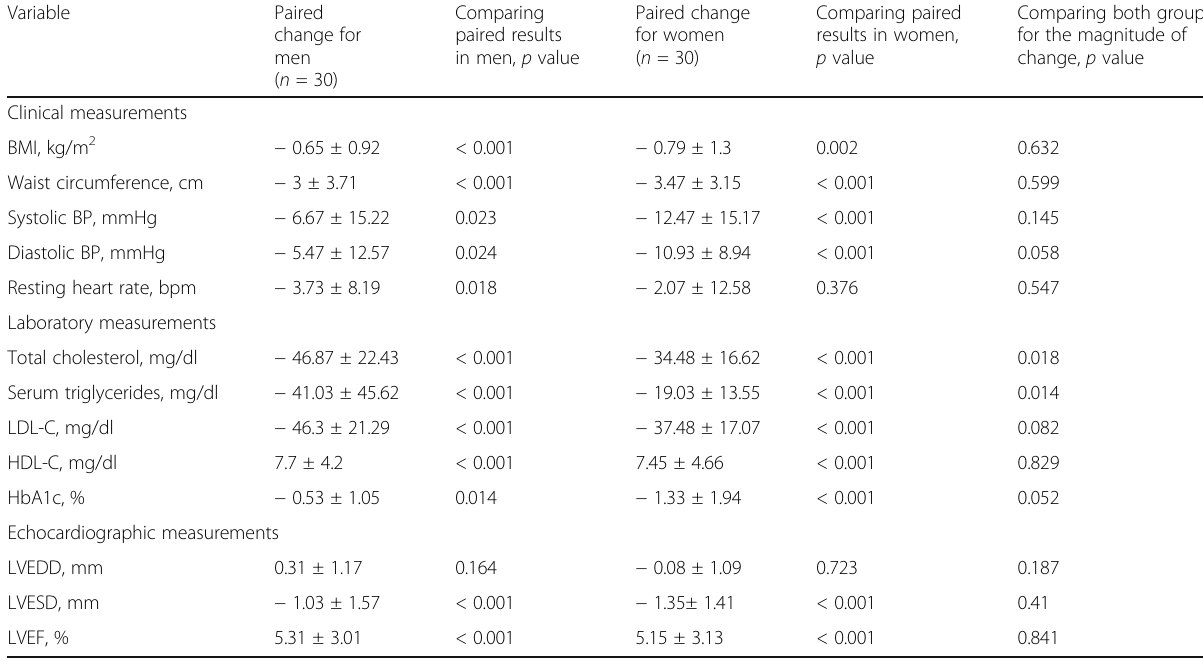
Table 4 Paired change in clinical, laboratory and echocardiographic measurements after completion of the cardiac rehabilitation program for each gender and comparison of the magnitude of change between them Variable Paired